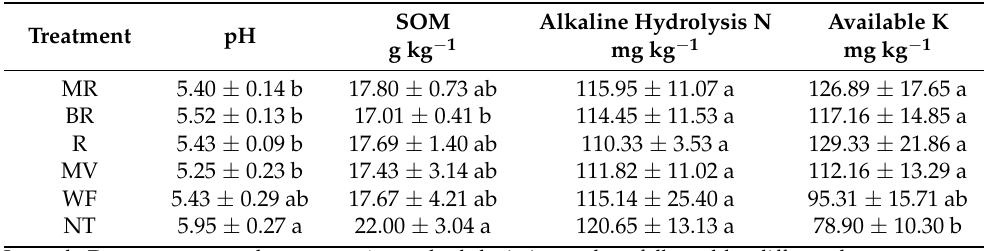
Table 2. Effects of different treatments on soil basic properties.